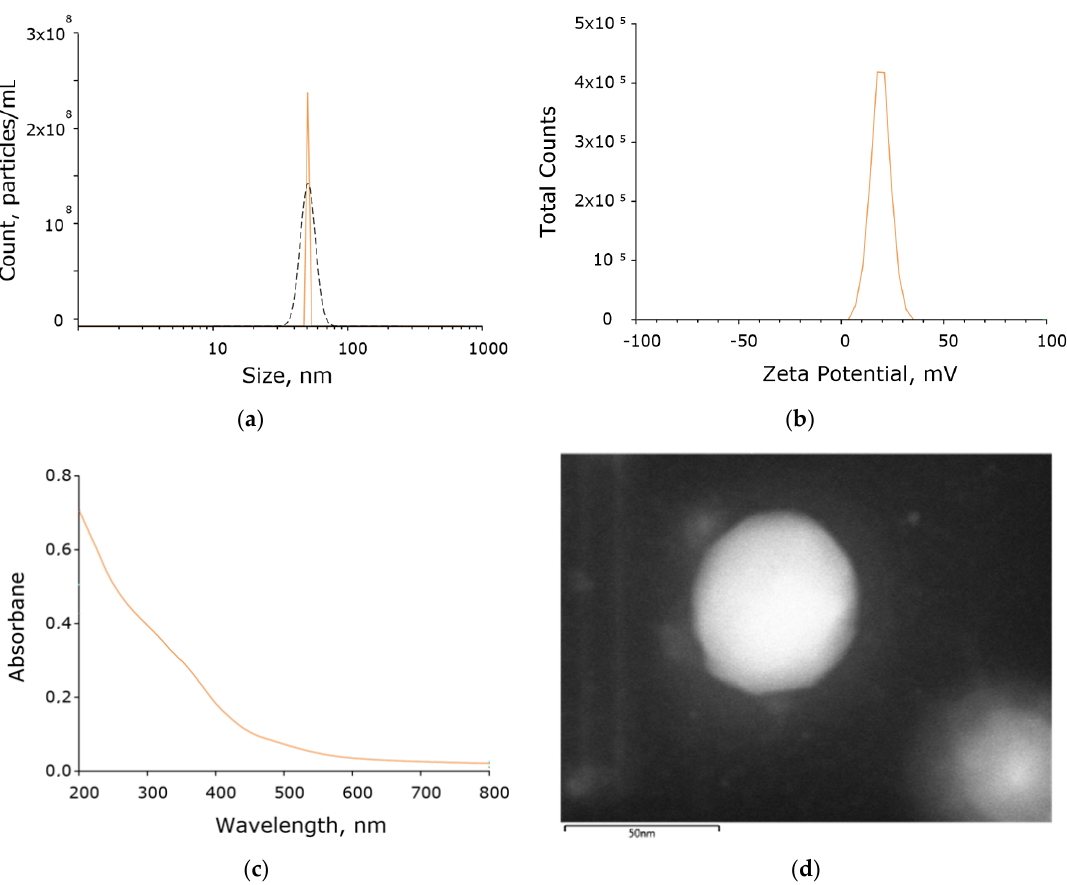
Figure 1. Physicochemical characteristics of a colloidal solution of iron oxide nanoparticles. Concentration (DLS, solid crimson line) and size distribution (CPS, black dashed line) of iron oxide NPs ( a ); zeta potential of iron oxide NPs ( b ); optical absorption spectrum of the obtained colloidal solution of iron oxide nanoparticles ( c ); TEM image of a single iron oxide nanoparticle ( d ). Using energy ‐ dispersive X ‐ ray spectroscopy (EDX), the chemical composition of the resulting nanoparticles was determined. The content of two elements in the composition of nanoparticles was revealed: iron and oxygen. It was found that the colloidal solution contained chemically pure nanoparticles without impurities, consisting of iron oxide (Figure 2a–c).